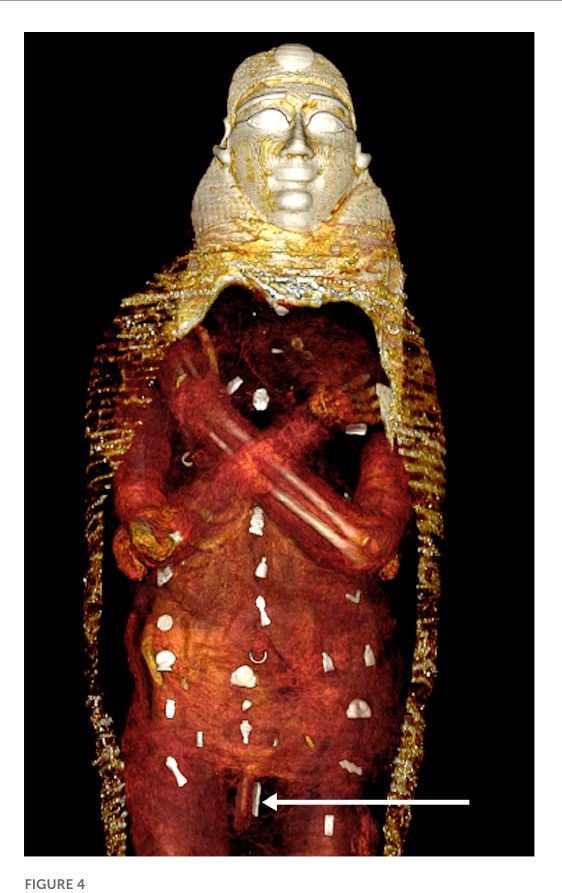
FIGURE4 Three-dimensional computed tomography (CT) image of the front of the digitally unwrapped torso of mummy TR 21/11/16 at the Cairo Egyptian Museum shows the crossed arms position and the amulets. The separately wrapped upper limbs are bent at the elbows and crossed in front of the chest. Amulets are seen arranged in three columns on the front surface of the torso. An amulet is placed beside the